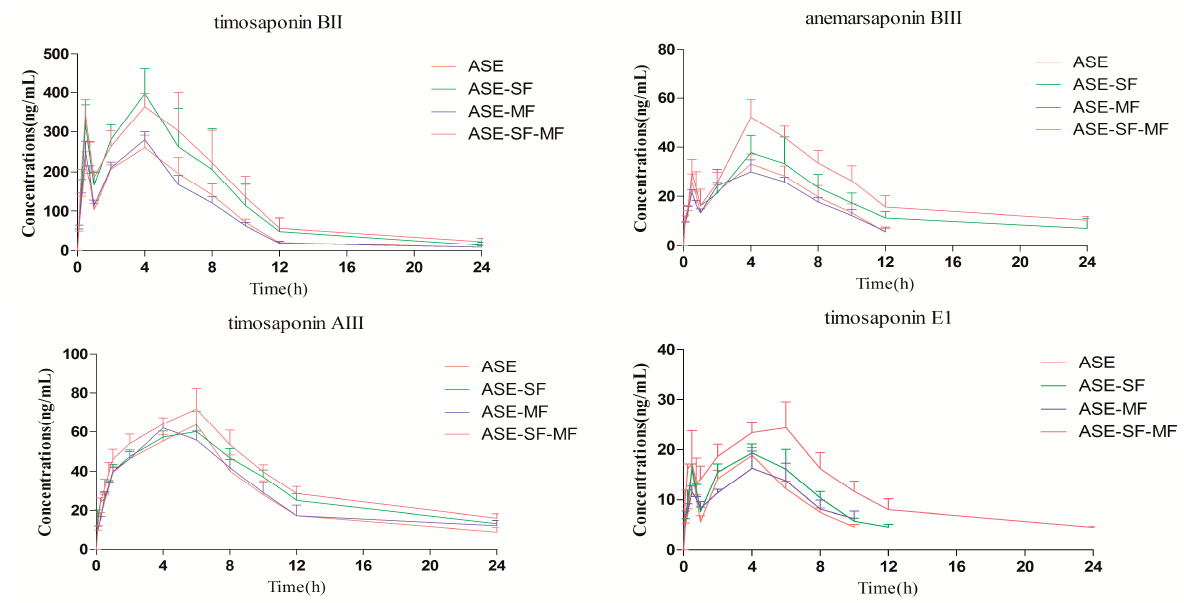
Figure 3. Mean plasma concentration-time curves of steroidal saponins.